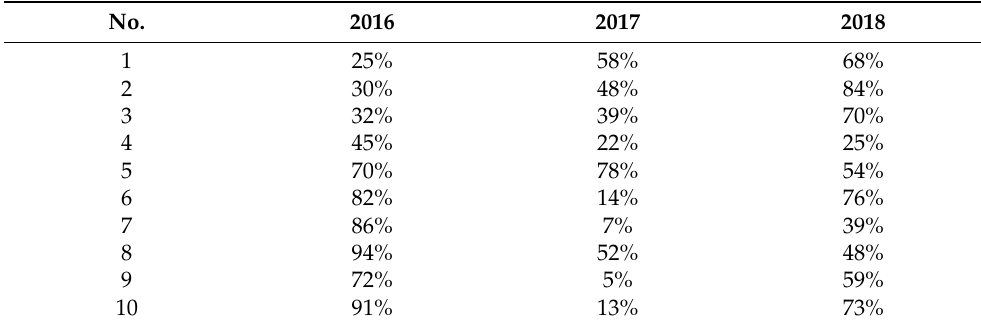
Table 1. Proportion of BSs among the current-year new shoots for 10 Sapindus mukorossi trees from 2016 to 2018. No.